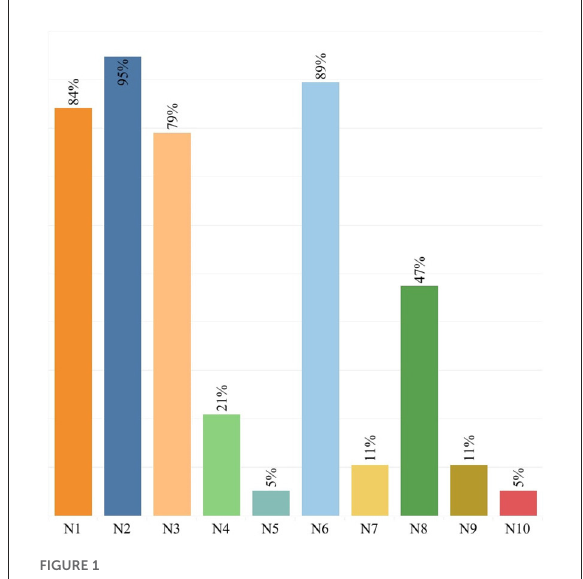
FIGURE1 Bar graph showing the percentage of articles vs. normalization methods.